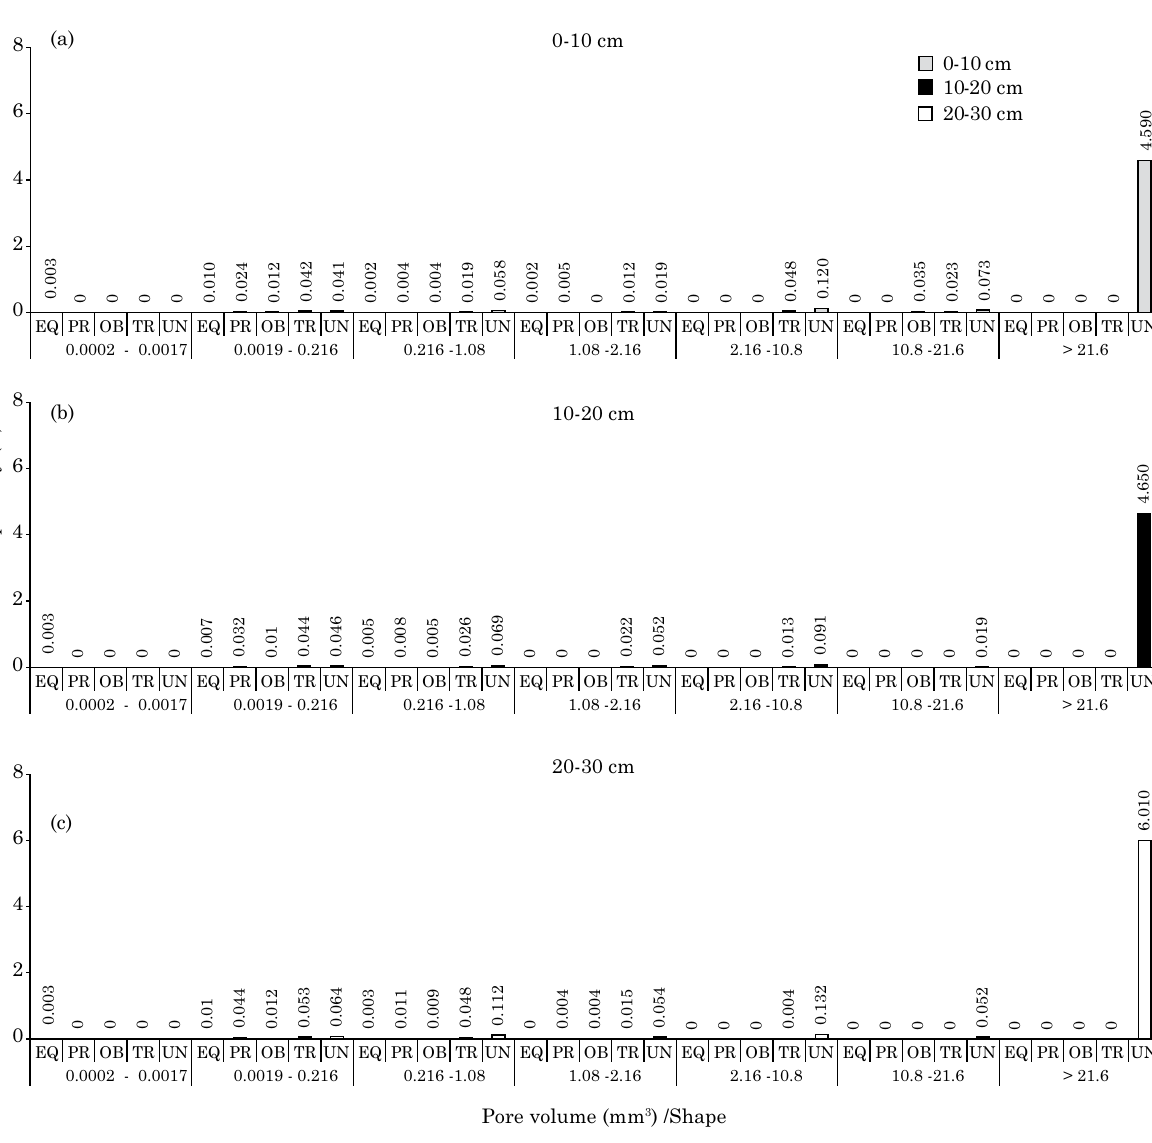
figure 8. macroporosity for each kind of pore in regard to size interval: (a) 0-10 cm layer, (b) 10-20 cm layer, and (c) 20-30 cm